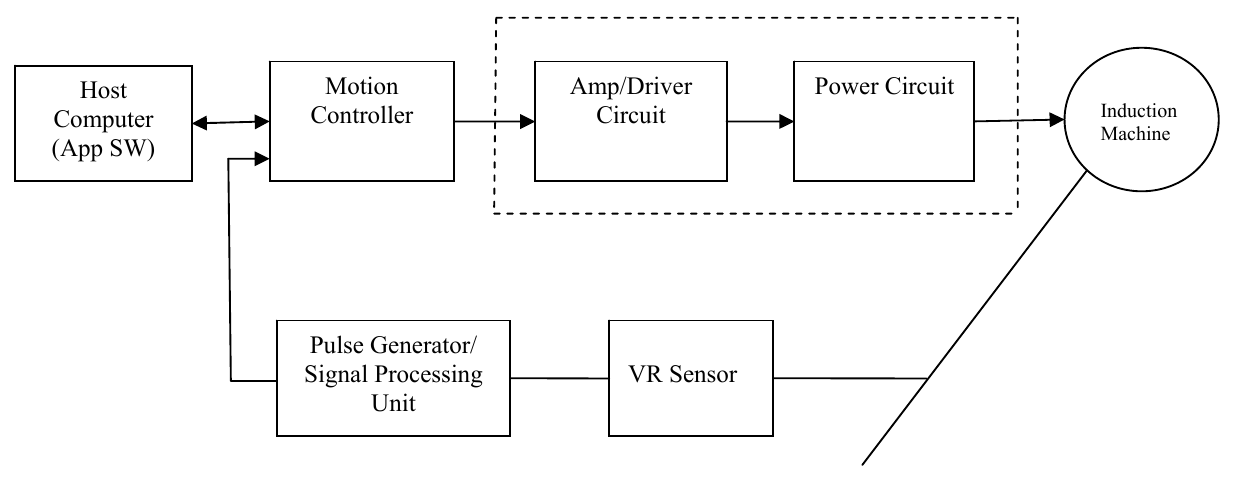
Figure 9. Main components of the proposed experimental